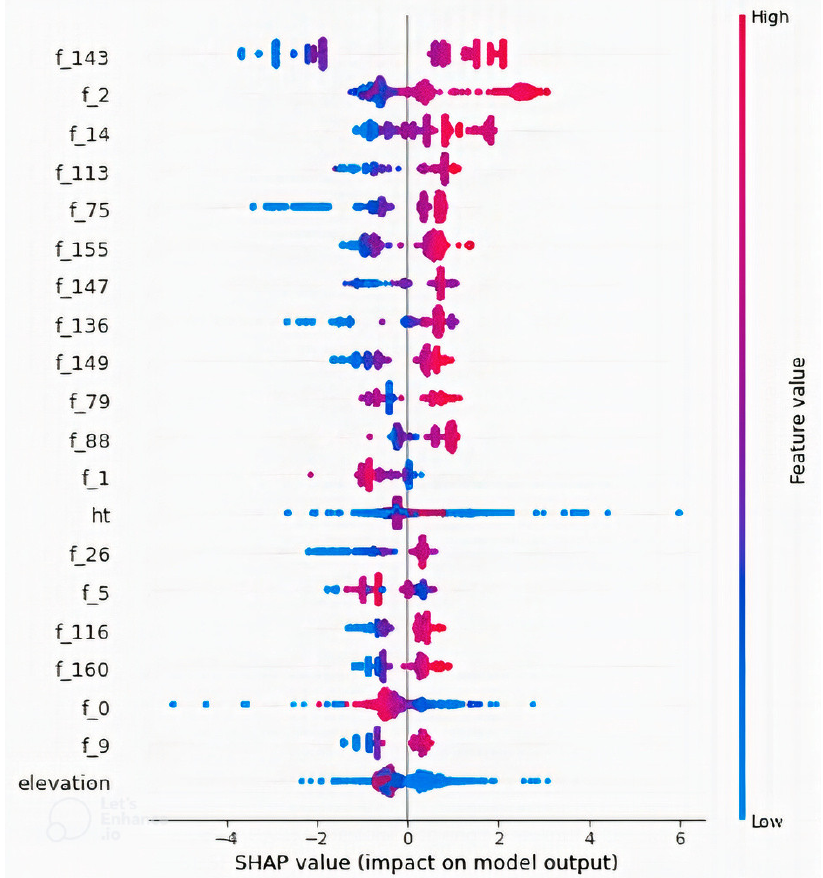
Figure 10. SHAP summary plot of the 20 most important features in the model developed with a combination of non-image features and CNN + GLCM features. It shows the variations in feature values with output path loss value.